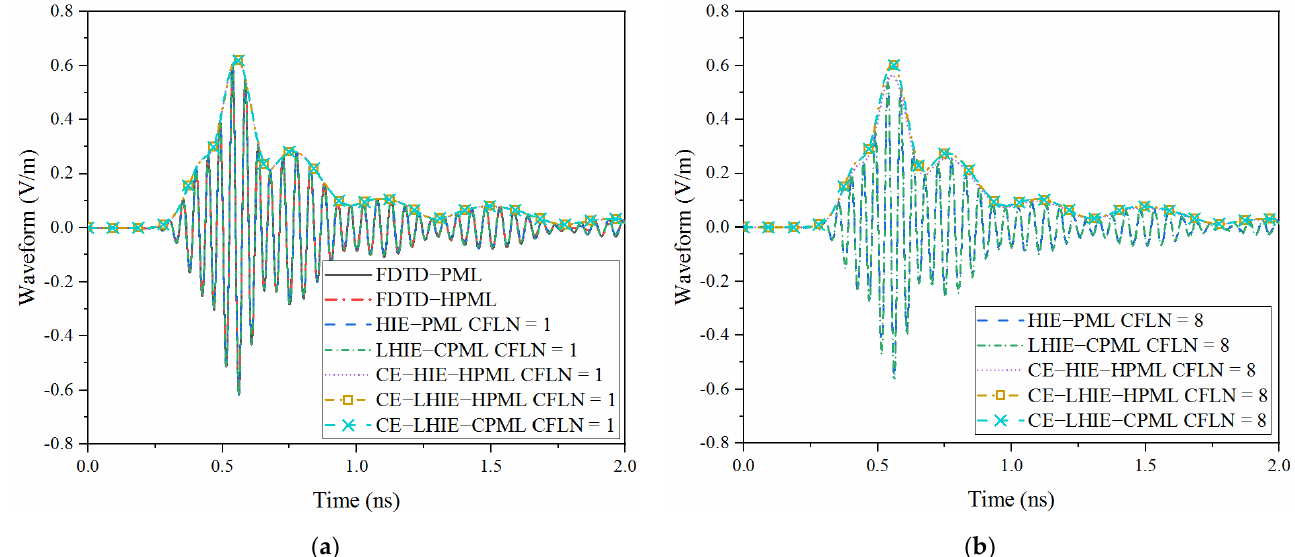
Figure 4. Waveform obtained by different PML algorithms at the observation point: ( a ) CFLN = 1; ( b ) CFLN = 8.